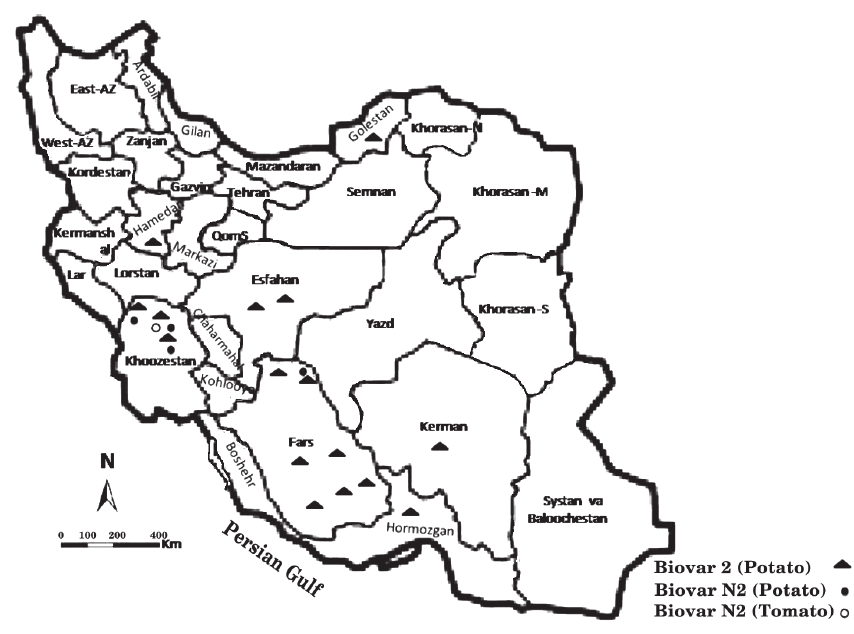
Figure 1. Locations in Iran where Ralstonia solanacearum isolates were